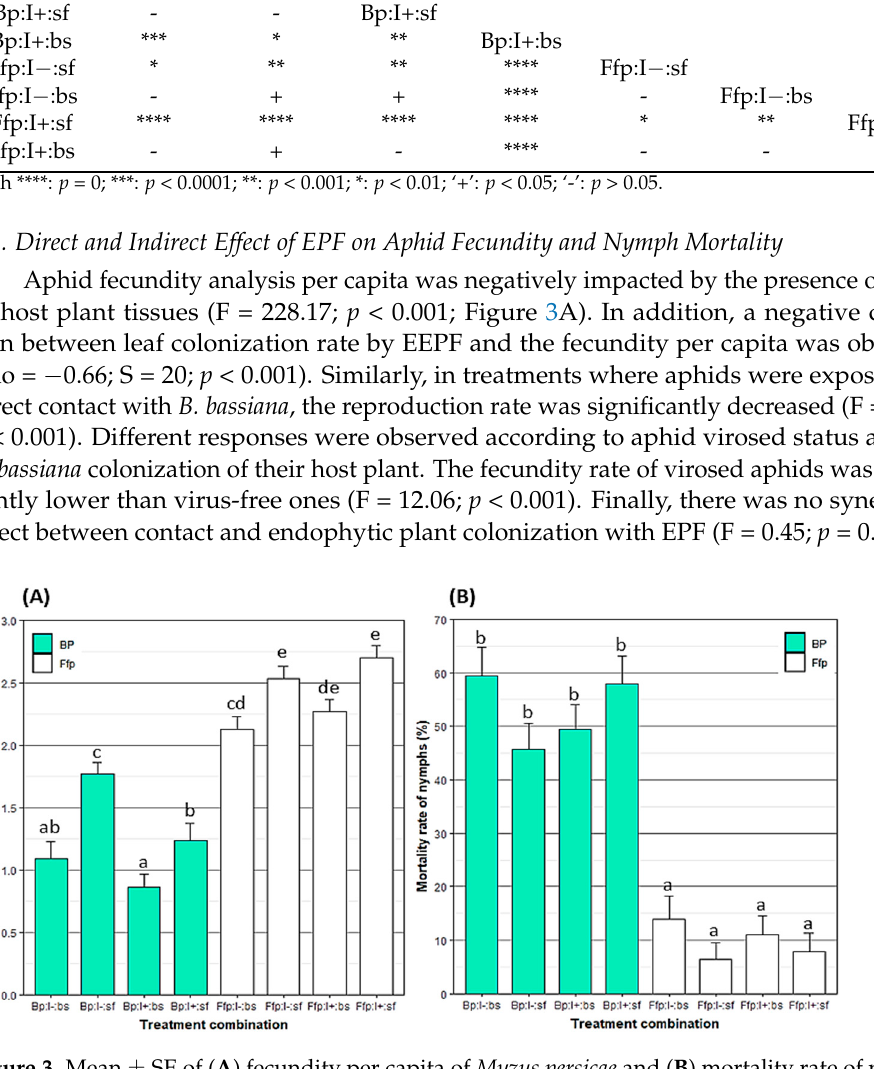
Figure 3. Mean ± SE of ( A ) fecundity per capita of Myzus persicae and ( B ) mortality rate of nymphs laid eight days after release on B. bassiana -inoculated or fungal-free plants. Treatments were based on combinations of plant type (Bp: B. bassiana -inoculated plant; Ffp: fungal-free plant), insect infectious status (I+: viruliferous; I − : non-viruliferous) and insect spraying (bs: with B. bassiana spore suspension; sf: with spore-free solution). Treatments followed by a different letter differ